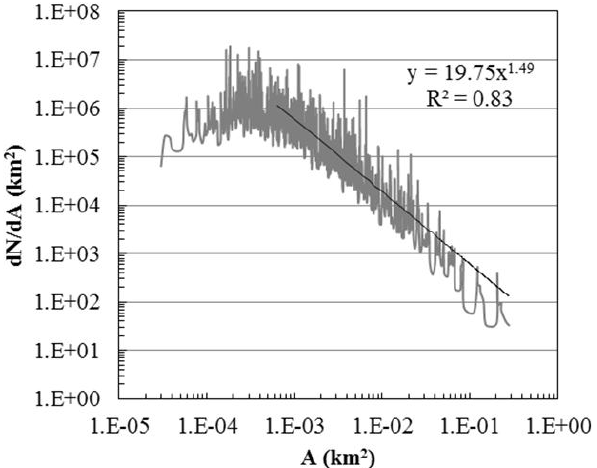
Fig. 4. Landslide area frequency plot. dn/dA is the derivative of landslide frequency with respect to the total area and A is the landslide